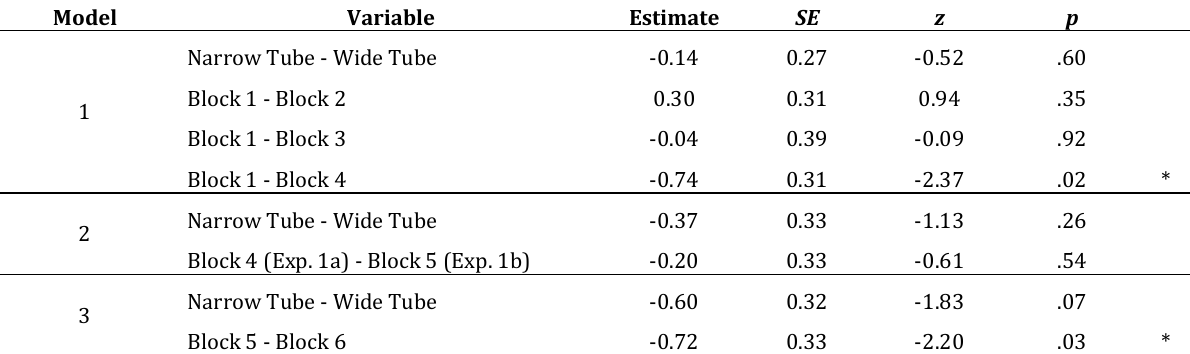
Results from Ordinal-logit Models Examining Whether the Proportions of Selection of the Three Tools Differed: i) According to the Condition (Wide or Narrow tube) and ii) Across Blocks of